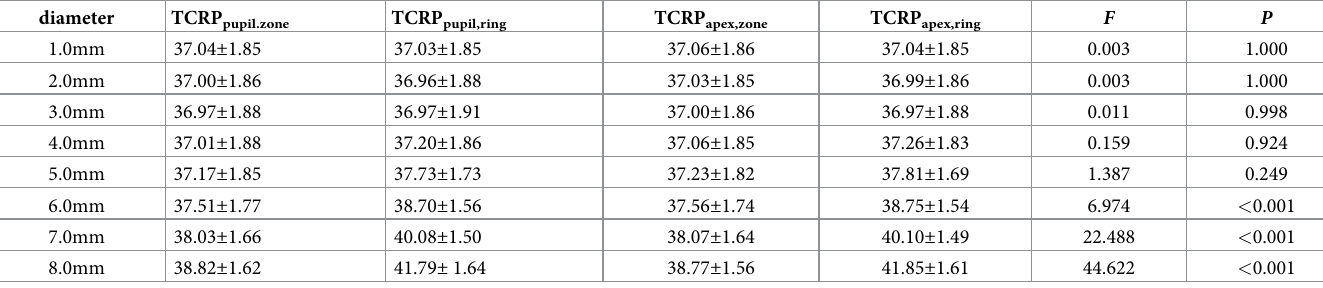
SMILE = small incision lenticule extraction; TCRP = total corneal refractive power TCRP pupil,zone /TCRP pupil,ring /TCRP apex,zone /TCRP apex,ring represent TCRP within a diameter of zone or ring centered at pupil axis or corneal